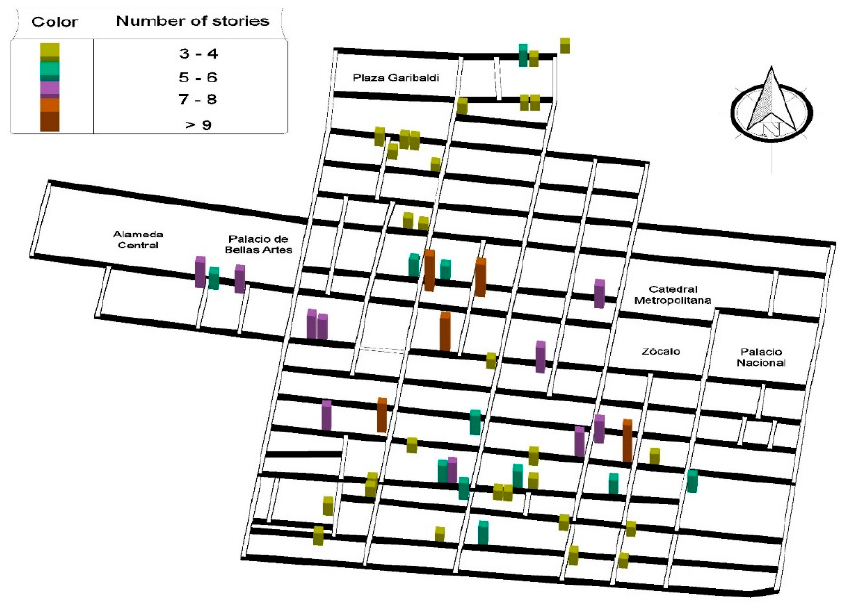
Figure 3. Example of reinforced concrete tilted buildings located in the highlighted area of Figure 2.